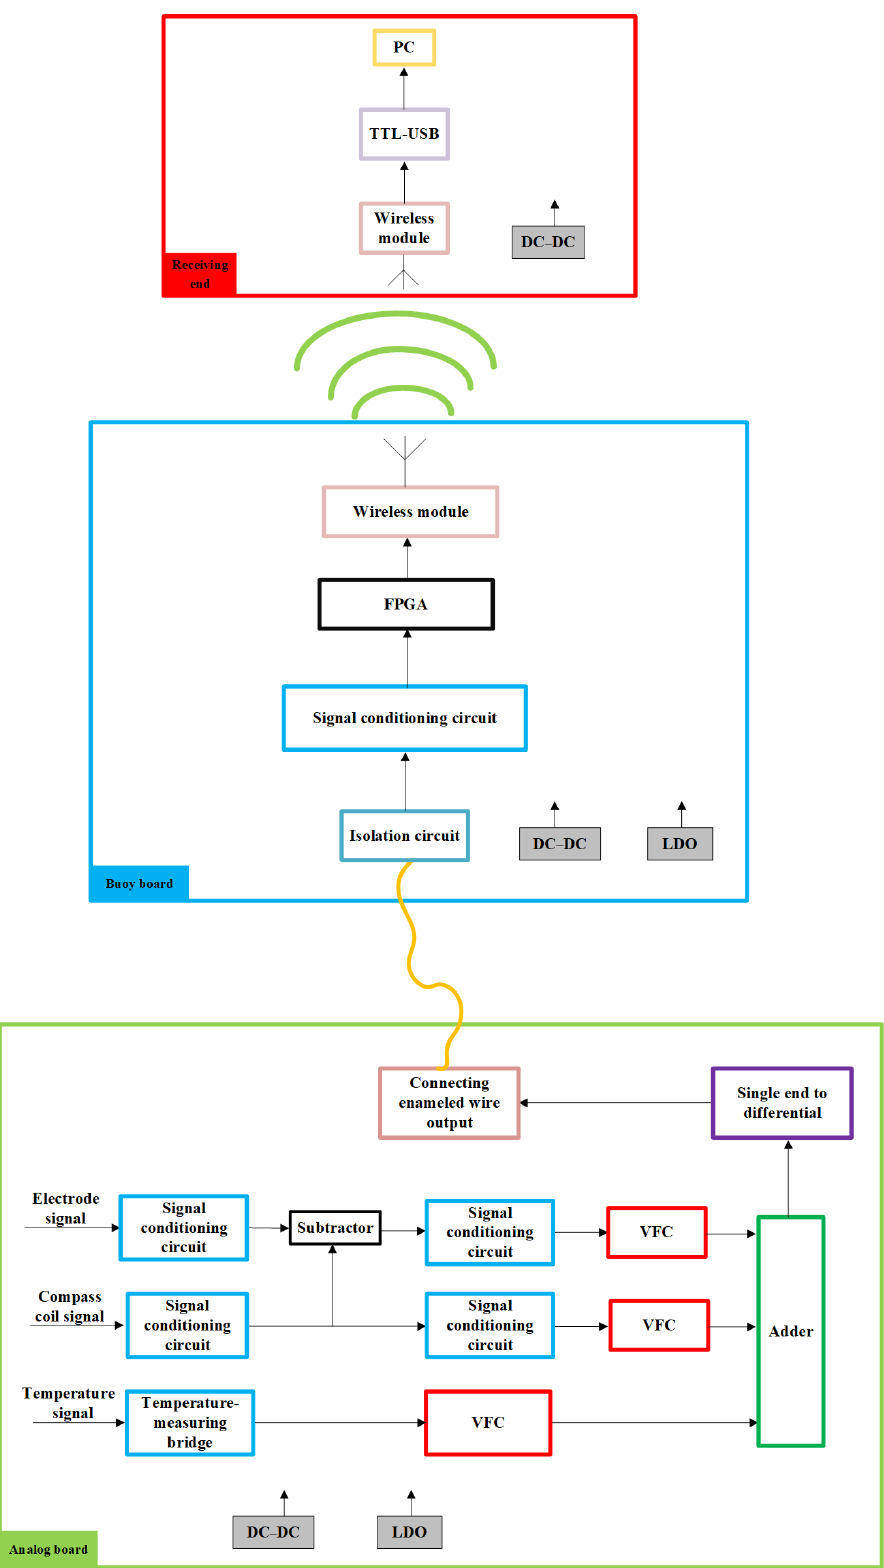
Figure 2. The overall architecture of the